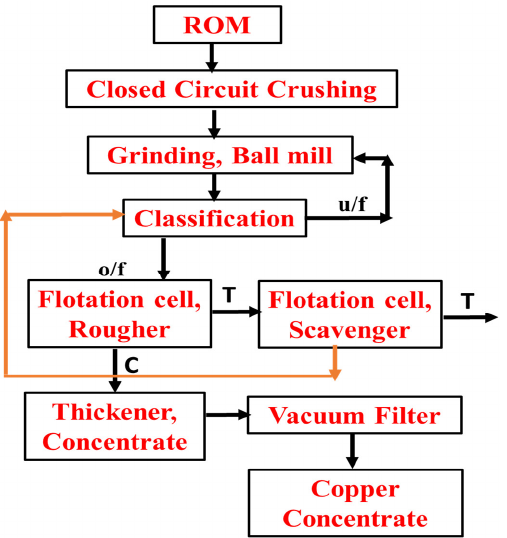
Figure 24. Mosabani copper concentrator plant flow sheet (India) [156].